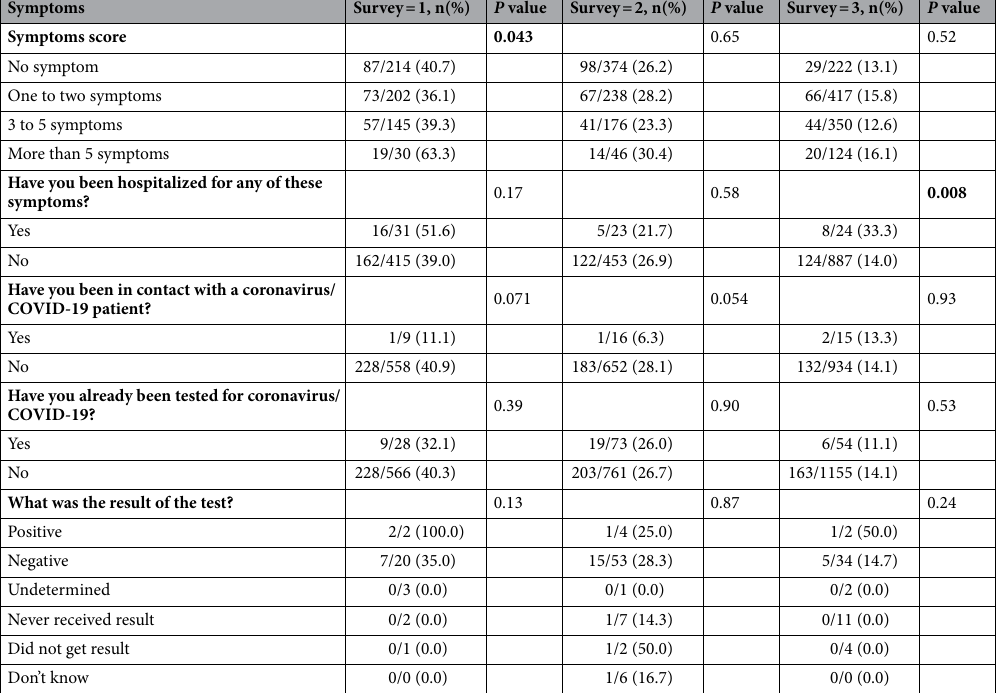
Table 3. Association of Flu symptoms with sero-positivity. Significant values are in